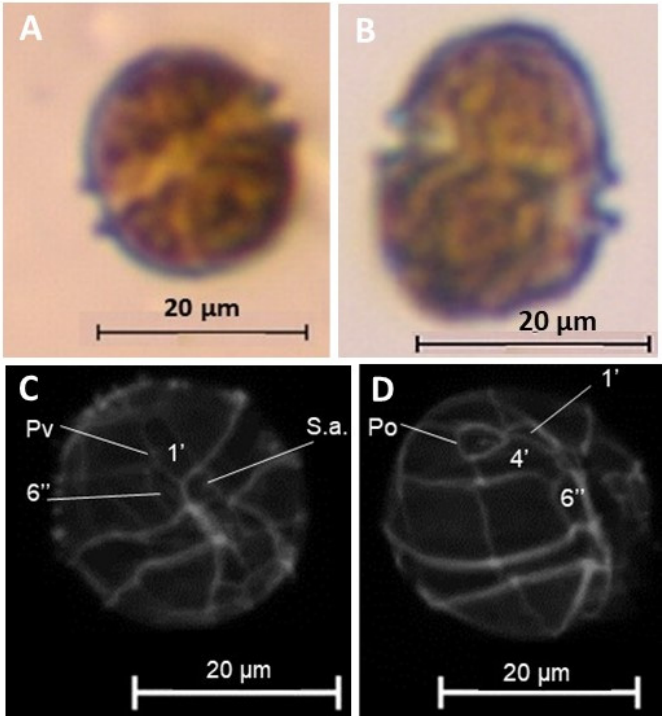
Figure 2 . A. minutum strain Am.6. ( A , B ) Light micrographs (LMs) of living cultured cells. ( A ) LM of dorsal view of cell. ( B ) LM of ventral view of cell. ( C , D ) Fluorescence microscopy of CalcoFlour-white-stained cells. ( C ) Ventral view showing the ventral pore (Pv) on the 1 ′ plate, the narrow 6 ″ plate, and the sulcal anterior plate (S.a.). ( D ) Lateral view showing the connection between the Po and the 1 ′ plate.